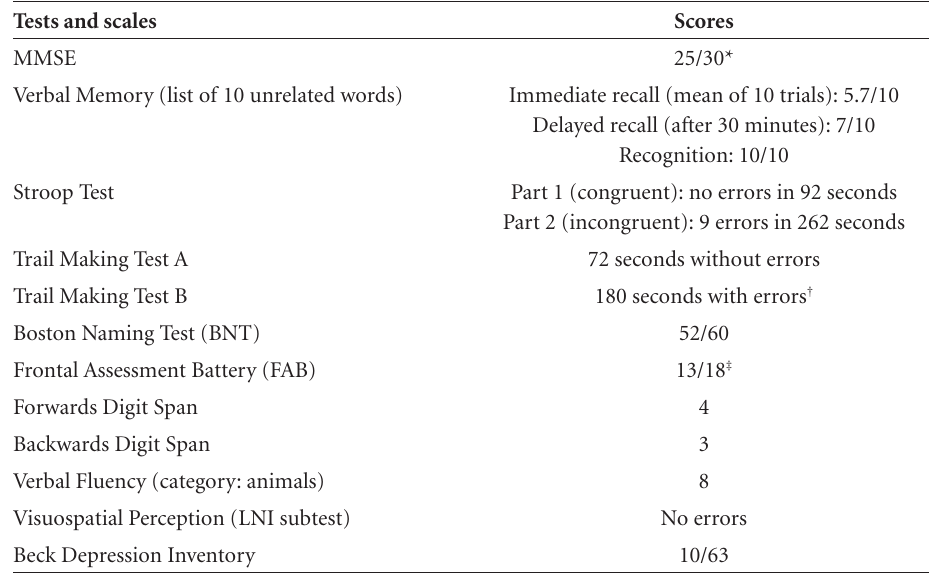
Table 1. Neuropsychological evaluation and depression